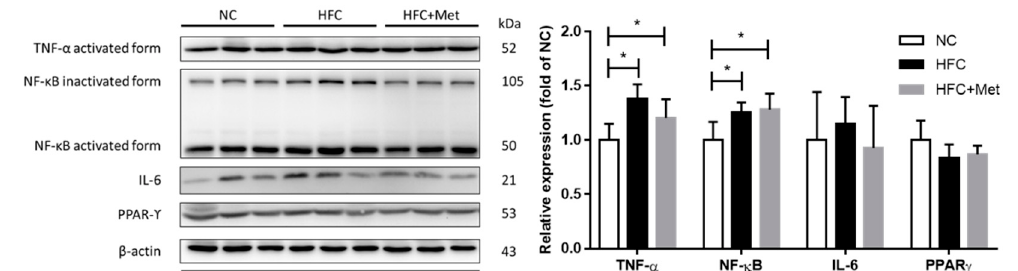
Figure 9. Effects of the high-fat and high-cholesterol diet and metformin supplementation on testicular inflammation pathway regulators (TNF- α , NF- κ B, IL6 and PPAR ϒ ) in the male mice: Protein expressions in each group were measured using western blot analysis, and β -actin was used for normalization. Data are expressed as means ± SD of duplicate experiments ( n = 6–9 per group). * p < 0.05 as determined by one-way ANOVA followed by LSD post hoc test. NC, normal diet; HFC, high-fat and high-cholesterol diet; HFC + Met, HFC with metformin supplementation. TNF- α , tumor necrosis factor- α ; NF- κ B, nuclear factor- κ B; IL-6, interleukin-6; peroxisome PPAR ϒ, proliferator-activated receptor ϒ .